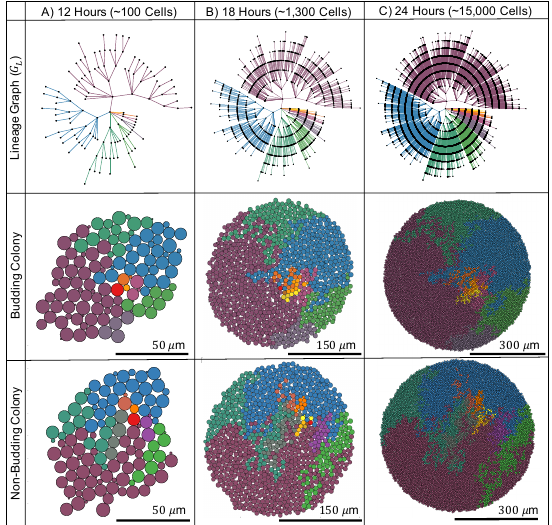
Figure 2. Simulated Yeast Colonies in Nutrient-Rich Conditions and Corresponding Lineage Relationships. We compared overall growth, shape and spatial organization between budding (Middle) and non-budding (Bottom) colonies. Colonies are depicted at three time points ( A ) 12 h ( ∼ 100 cells); ( B ) 18 h ( ∼ 1300 cells) and ( C ) 24 h ( ∼ 15,000 cells). In addition to the physical layout of cells, we analyzed two different networks associated with our colonies, the lineage graph ( G L , Top) and the spatial graph ( G S , see Section 4.2.2). (Top row) The lineage graph ( G L ) represents mother-daughter relationships and does not consider cell position in space. Assuch,thelineagegraphisthesameforthetwodifferentcoloniesdepictedbelow(buddingandnon-budding). Cells in colonies and edges in the lineage graph are colored according to the unique subcolony each cell belongs to, where a subcolony is the subset of all cells whose common ancestor is the same immediate daughter of the founder cell: Founder (red), Subcolony 1 (maroon), Subcolony 2 (blue), Subcolony 3 (dark green), Subcolony 4 (light green), Subcolony 5 (lavender), Subcolony 6 (purple), Subcolony 7 (dark orange), Subcolony 8 (gold), Subcolony 9 (yellow), Subcolony 10 (rust), Subcolony 11 (magenta), Subcolony 12 (light pink) and Subcolony 13 (grey). Lineage graphs display the first five subcolonies only. (See Section 4.2.2 for